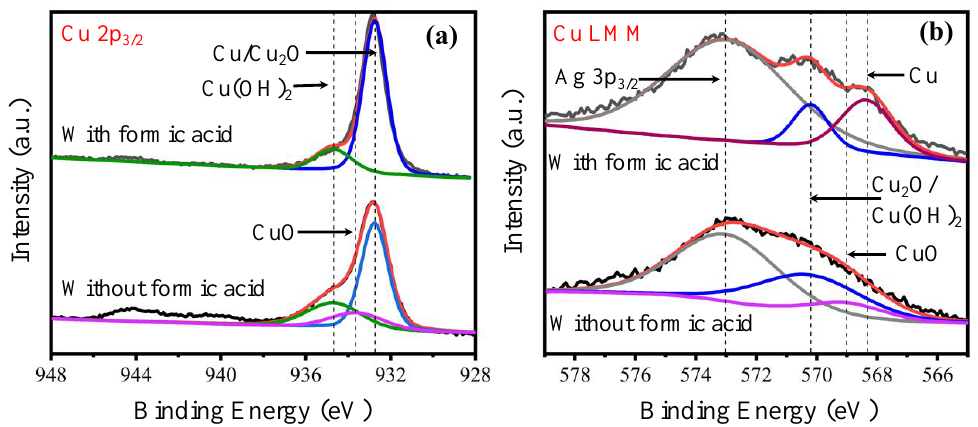
Figure 9. XPS spectra of the Cu surfaces after removal of the sintered Ag layer: ( a ) Cu2p 3/2 and ( b ) Cu LMM.